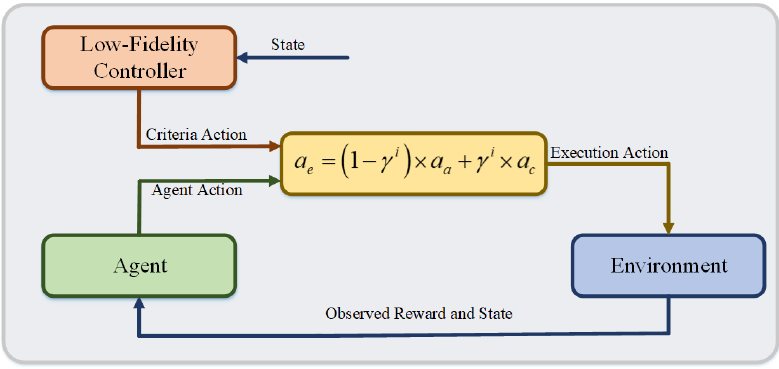
Figure 5. Knowledge-assisted learning method—criteria action